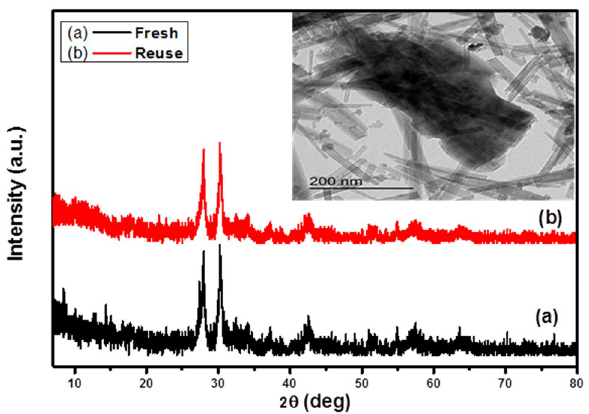
Figure 9. Effect of reuse on the structural properties of 10% rGO/FeVO 4